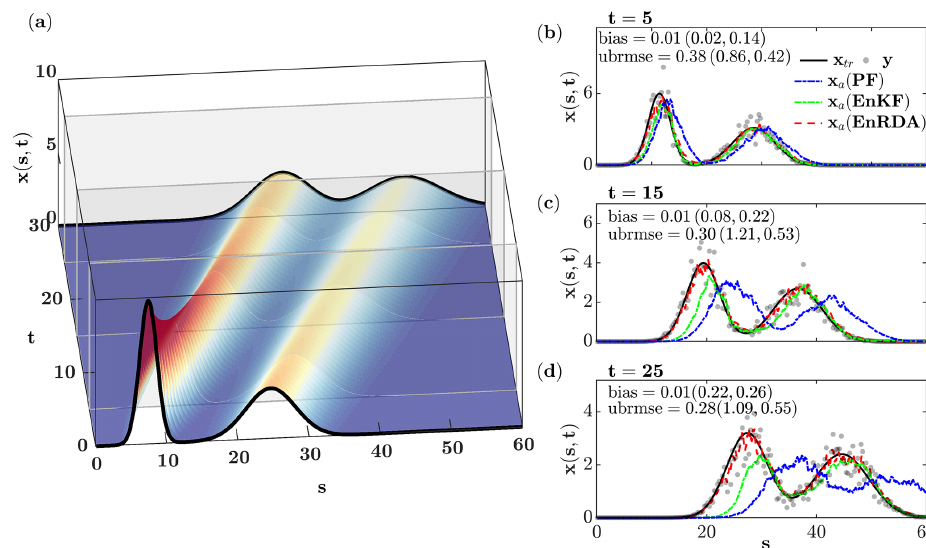
Figure 5. (a) Temporal evolution of a bimodal initial state under a linear 1-D advection–diffusion equation (b) – (d) by the particle filter (PF), ensemble Kalman filter (EnKF), and ensemble Riemannian data assimilation for three time snapshots at 5, 15, and 25 (T). The bias and ubrmse of the analysis states are also reported in the